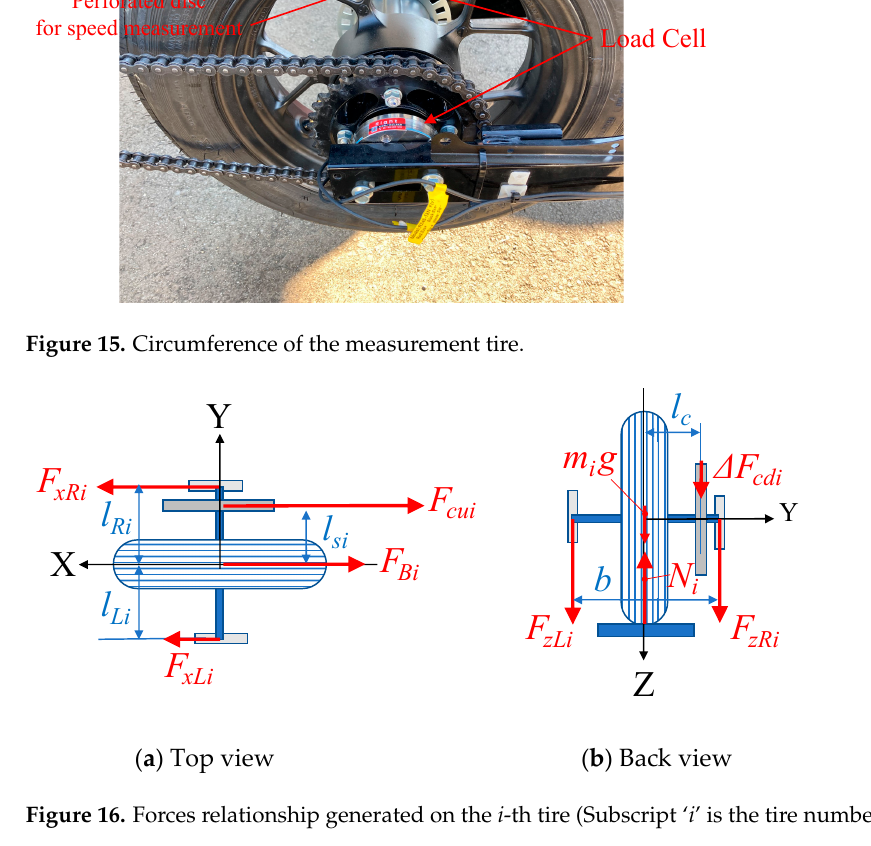
Figure 16. Forces relationship generated on the i -th tire (Subscript ‘ i ’ is the tire number). For the X -axis forces: